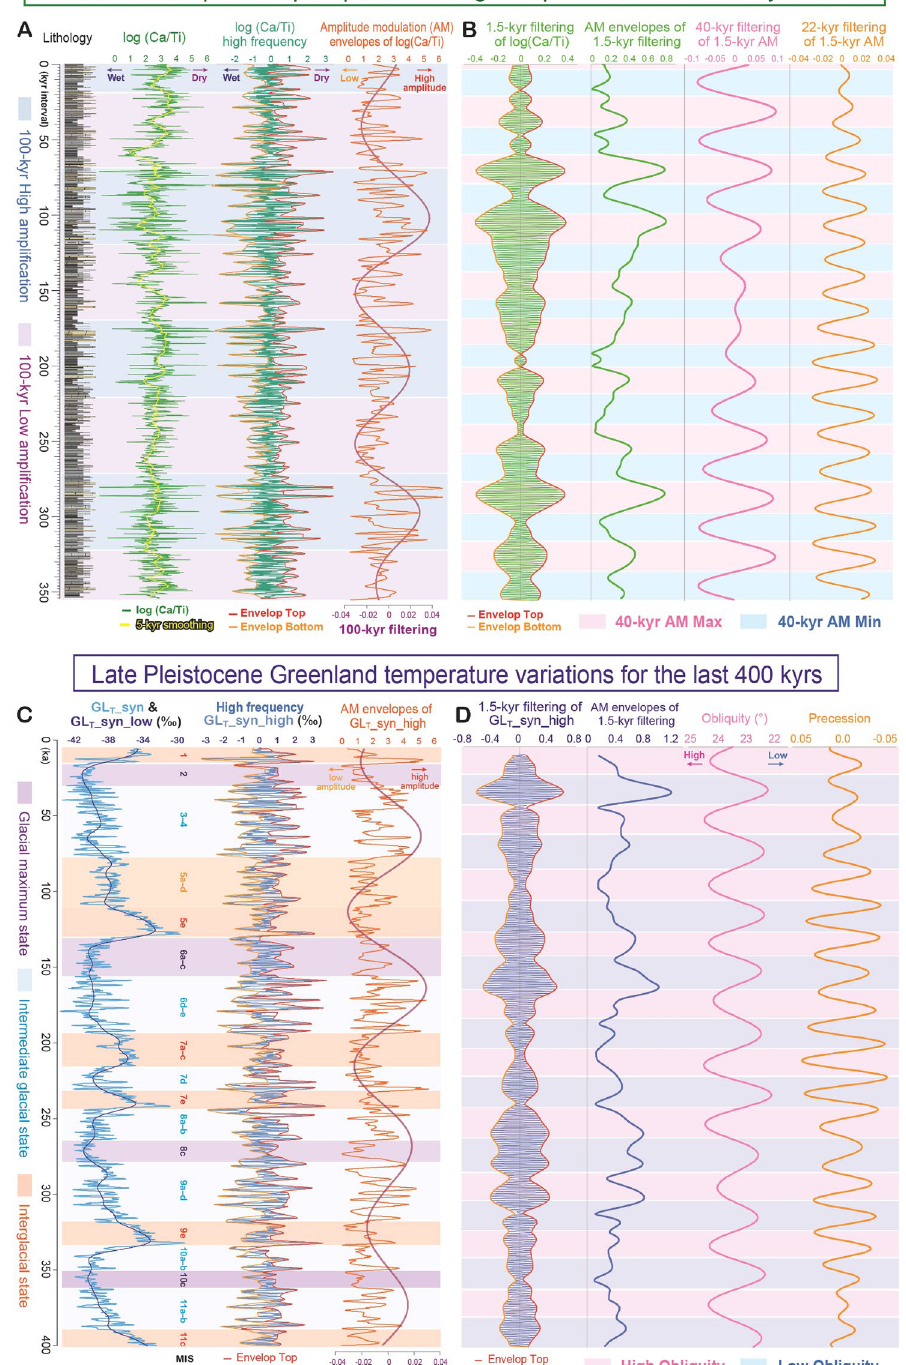
Figure 5. Comparison of millennial-scale variation patterns between the Cretaceous lacustrine deposits ( A,B ) and the late Pleistocene Greenland temperature record ( C,D ). ( A ) Lithology, log (Ca/Ti) with 5-kyr smoothing, high frequency (< 5-kyr) variations of log (Ca/ Ti) with envelop top and bottom (2.5-kyr sliding windows), and AM envelopes (subtraction of envelop top and bottom) of log (Ca/ Ti) high frequency with its AM of 100-kyr filter (purple; frequency: 9.5e-6; bandwidth: 5.0e-6) for a ~ 355-kyr interval of CSH01 core. ( B ) 1.5-kyr filtering (frequency: 6.7e-4; bandwidth: 4.0e-5) of log (Ca/Ti) with envelop top and bottom (2.5-kyr sliding windows), AM envelopes of 1.5-kyr filtering of log (Ca/Ti), 40-kyr filtering (frequency 2.5e-5; bandwidth: 2.0e-5) and 22-kyr filtering (frequency 4.5e-5; bandwidth: 1.0e-5) of 1.5-kyr AM of log (Ca/Ti). ( C ) Greenland temperature variability record (GL T _syn and GL T _syn_high) 7 of the last 400 kyrs. AM envelopes (2.5-kyr sliding windows) of GL T _syn_high with its AM of 100-kyr filter (purple; frequency: 1.0e- 5; bandwidth: 2.0e-6) are also shown. ( D ) 1.5-kyr filtering (frequency: 6.7e-4; bandwidth: 4.0e-5) of GL T _syn_high, AM envelopes (2.5-kyr sliding windows) of 1.5-kyr filtering, and obliquity and precession cycles for last 400 kyrs. Note that abrupt millennial-scale oscillations in both Cretaceous lacustrine Ca/Ti ratio and Greenland temperature variability show distinct AM by the obliquity and eccentricity cycle band (see also Boulila et al. 22 for AM of DO-scale variability of half-precession and precession cycle bands during the last glacial and the Late Jurassic